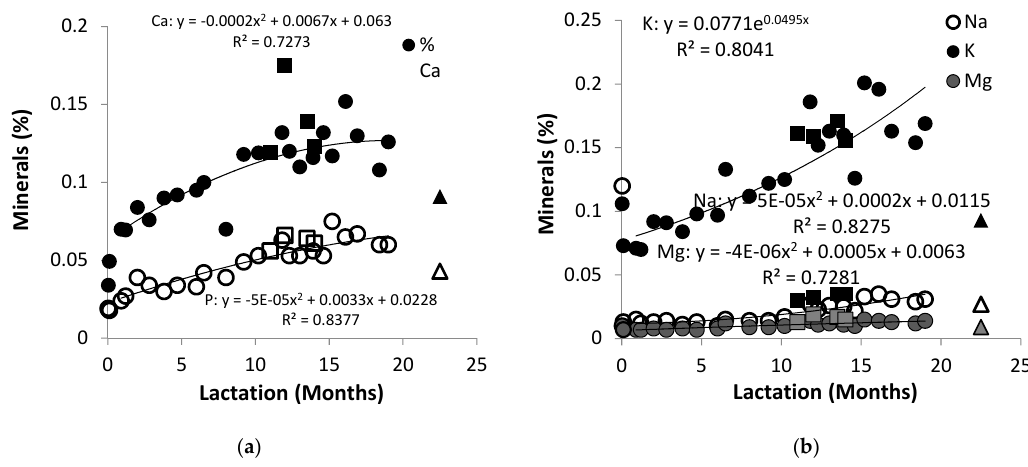
Figure 1. Changes of the ash content in milk of three African elephants during lactation (Shorty ( ● ), Mussina ( □ ), and Shan ( Δ )). The trend line of combined data of all animals was y = 0.0122x + 0.1671 and R 2 = 0.8297.